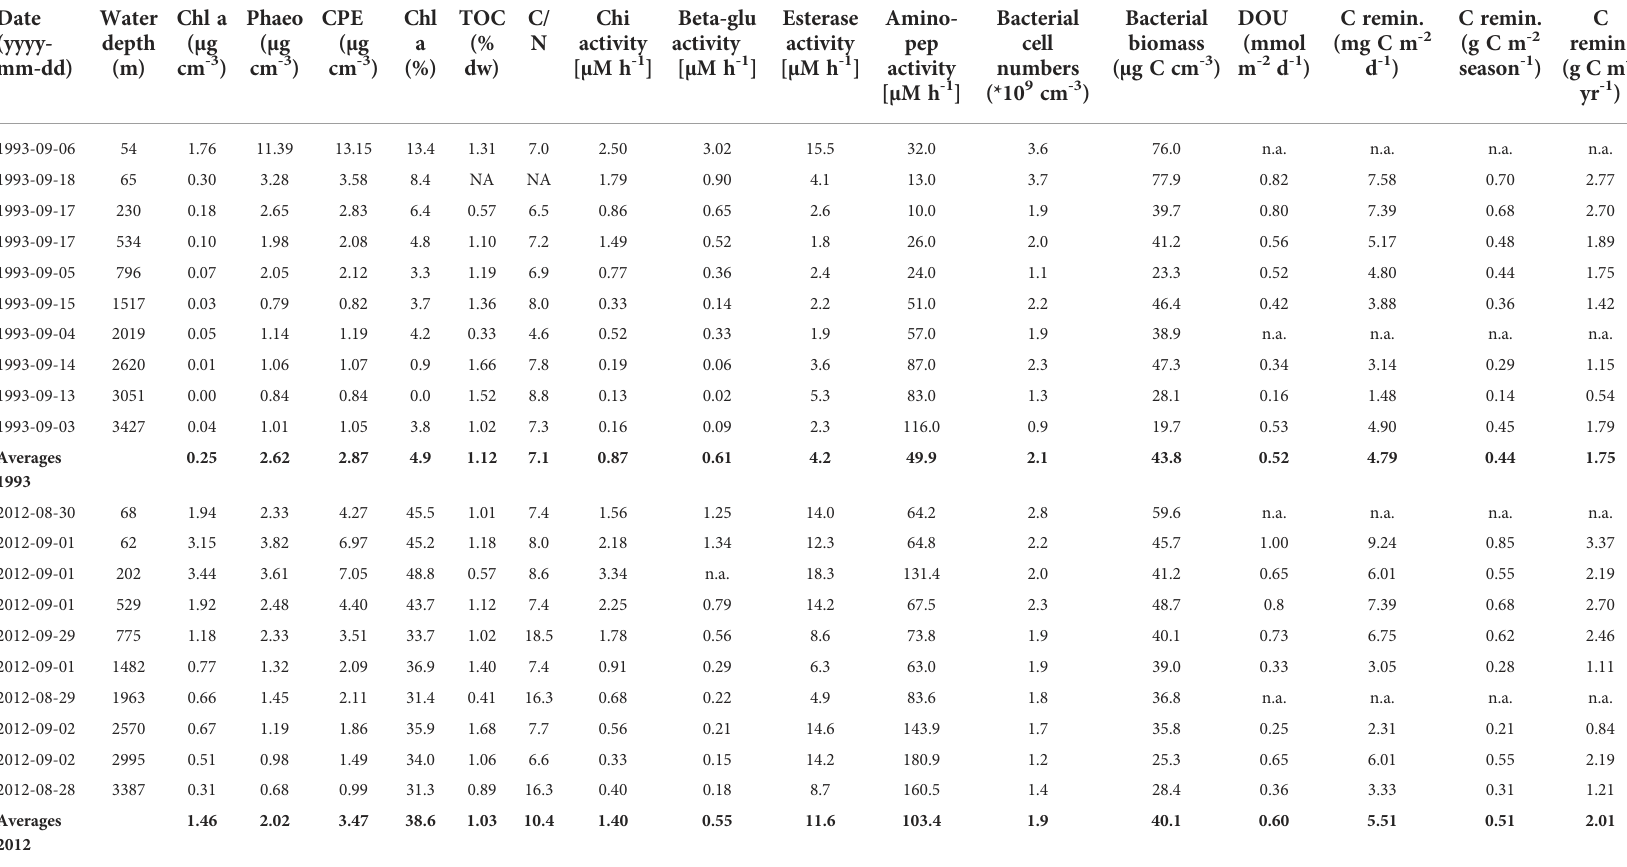
TABLE 5 Benthic biogeochemical variables determined in surface sediments (0-1 cm) down the Laptev Sea continental slope in September 1993 and August/September 2012. Date